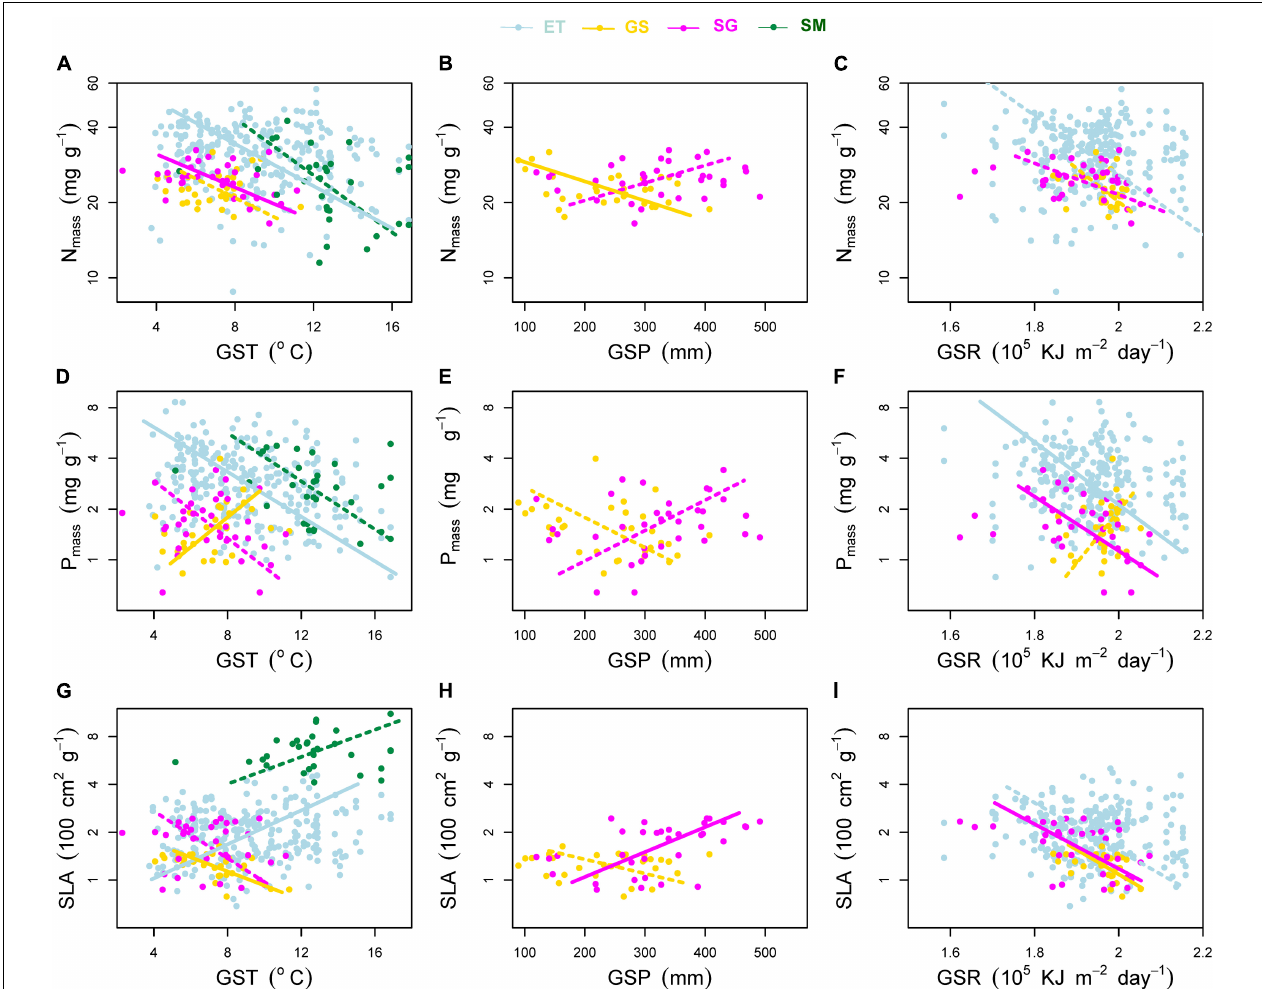
FIGURE 5 | Effects of environmental factors on (A–C) mass-based leaf nitrogen concentration (N mass ), (D–F) mass-based leaf phosphorus concentration (P mass ) and (G–I) specific leaf area (SLA). Environmental factors include growing season mean air temperature (GST), growing season mean precipitation (GSP), and growing season mean solar radiation (GSR). ET, emergent plants, GS, grasses, SG, sedges, and SM, submerged plants. Solid lines denoted that the environmental factors affected the plant traits significantly at significance level p < 0.05, while the dashed lines showed non-significant